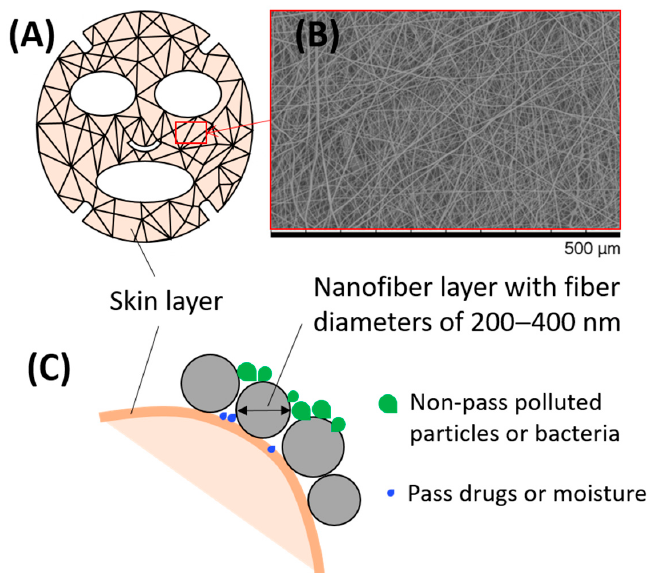
Figure 5. ( A ) A protective cosmeceutical mask for facial skincare after burns based on ( B ) a chitosan nanofiber membrane. ( C ) Schematic illustration of the nanofiber layer on the skin surface. Depending on the materials and active ingredients used in formulation for manufacturing, the nanofiber face mask can exhibit various functionalities, including increased contact area with the skin, protection of the skin from microsized polluted particles and bacteria, and maintenance of skin conditioning and moisture.